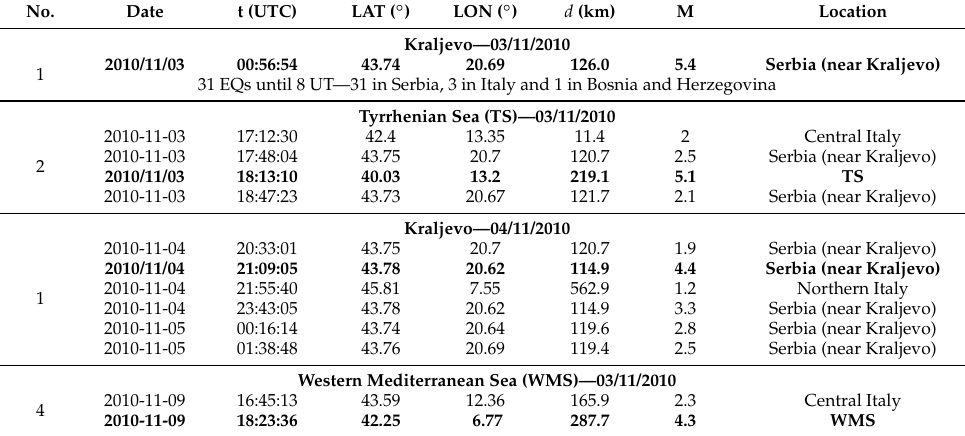
Figure 1. Propagation paths of the VLF signals recorded by the Belgrade receiver station (BEL) in Serbia and emitted by the transmitters ICV in Italy. Locations of the main considered EQs are shown as stars. One EQ occurred in the Tyrrhenian Sea (TS) and Western Mediterranean Sea (WMS), while two EQs were near Kraljevo (their epicentres are shown by the same star). Table 1. List of the main earthquakes considered in this study. EQ date, time t , epicentre locations (latitude (LAT) and longitude (LON)) and magnitudes (M) are given in http://www.emsc-csem.org/ Earthquake/(accessed on 25 February 2021). The variable d denotes the distance between the EQ epicentres and signal propagation